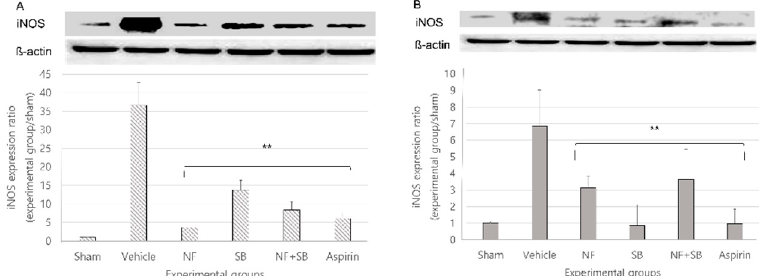
Figure 7. NF downregulates the expression of iNOS in the sciatic nerve ( A , B ) at the 7th and 14th day following the nerve crush injury. The density data are the mean ± SEM values of experiments. (* p < 0.05, ** p < 0.01 vs. vehicle group, Kruskal–Wallis test followed by a post hoc Mann–Whitney U test).